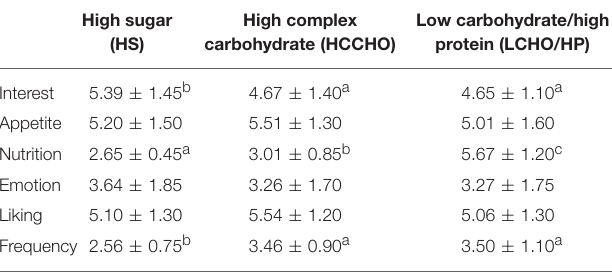
FIGURE 1 | Scatterplot depicting the relationship between FPQ and MaPS liking scores by image category. Overall trendline R 2 = 0.5422, p <